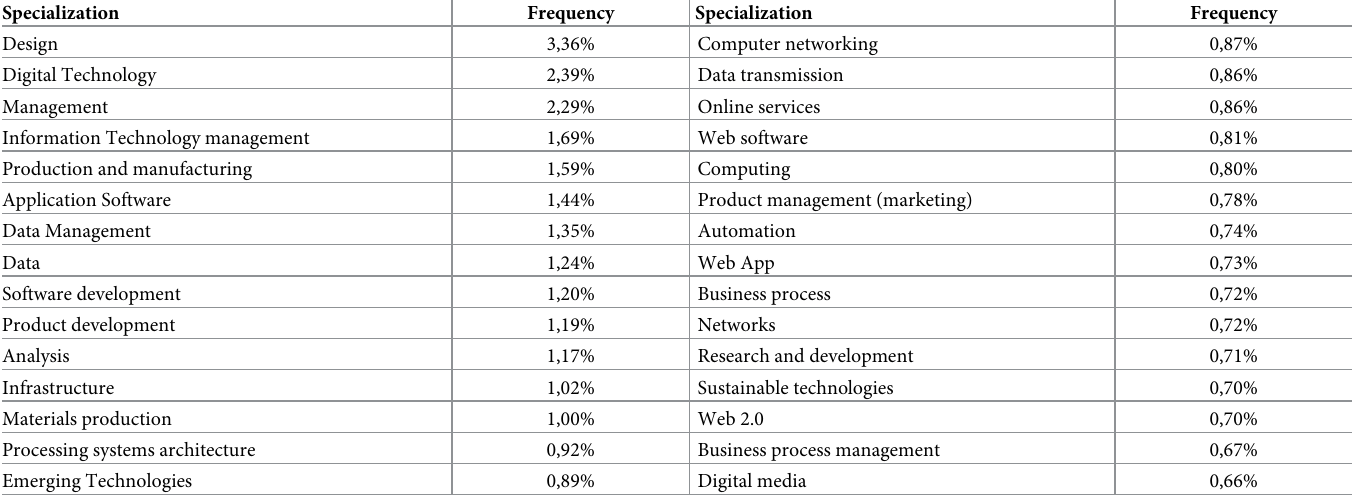
Table 3. Top 30 specializations and relative